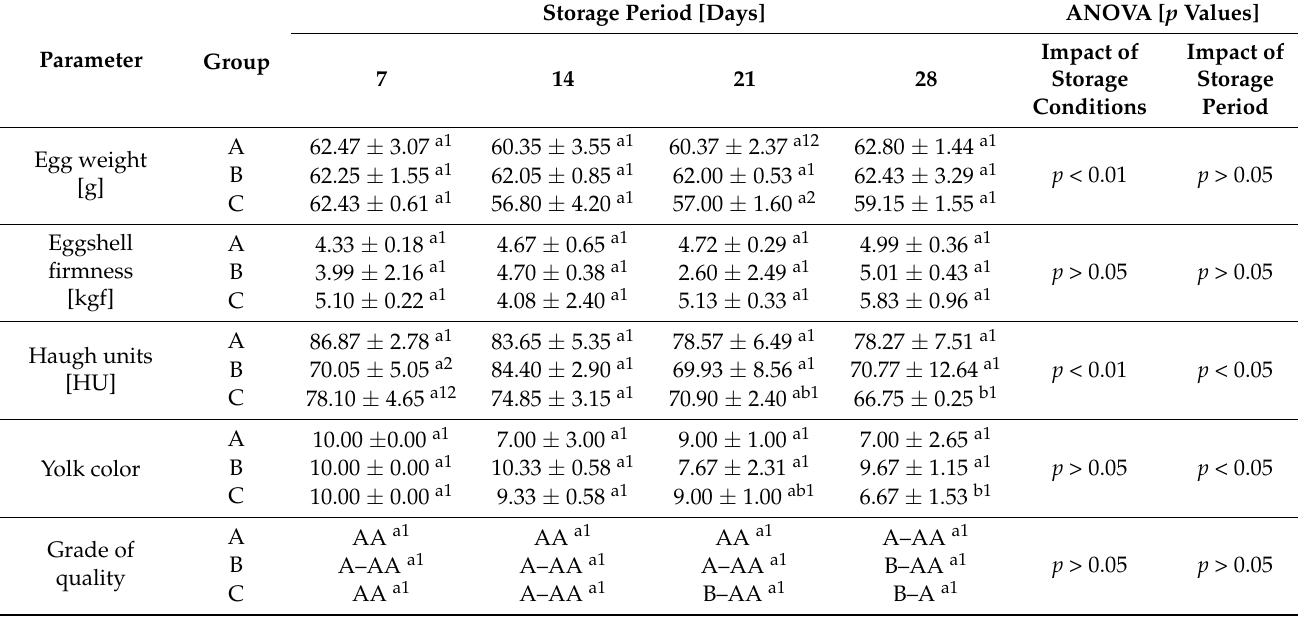
units decreased continuously within the storage period. At the end of experiment (Day 28), most eggs had to be downgraded to Grade B. Table 5. Egg quality parameters in three experimental groups of table eggs (A–C) during storage (mean ± SD). Storage Period [Days] Parameter Group